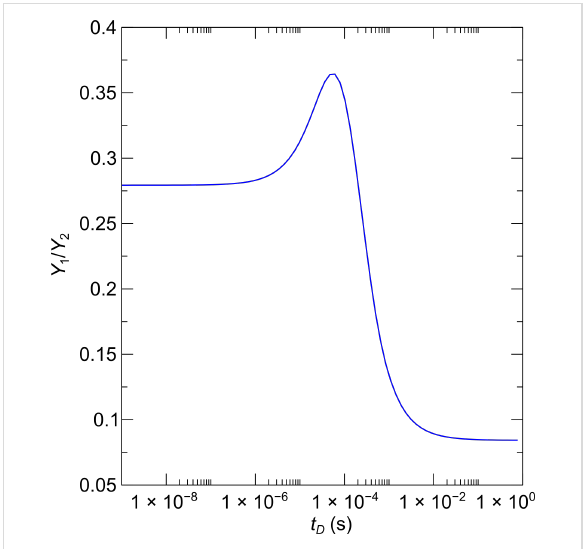
Figure 11: Dependence of the yield ratio for the precursors Co 2 (CO) 8 and Me 3 Pt(IV)CpMe on the dwell time within the multicomponent continuum model of FEBID. See text for